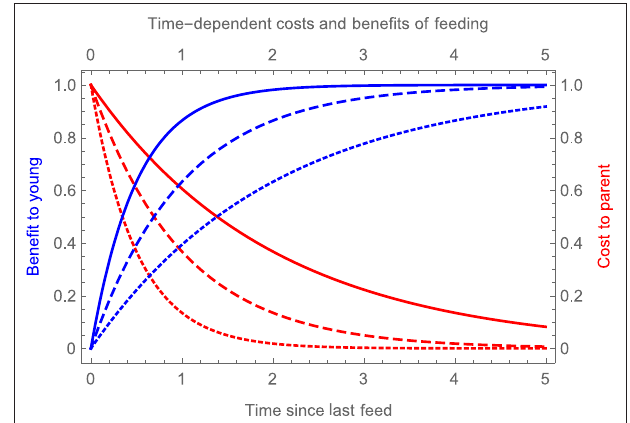
l FIGURE 3 | Time dependent costs and benefits of feeding. Blue curves show the benefit to the young of receiving a feed (relative to the maximum possible benefit), as a function of the time since they were last fed, for three different values of h (solid blue curve, h = 2; dashed blue curve, h = 1; dotted blue curve, h = 0.5). Red curves show the cost to a parent of delivering a feed (relative to the maximum possible cost) as a function of the time since it last fed, assuming that r f = r m = r , for three different values of r (solid red curve, r = 0.5; dashed red curve, r = 1; dotted red curve, r = 2).